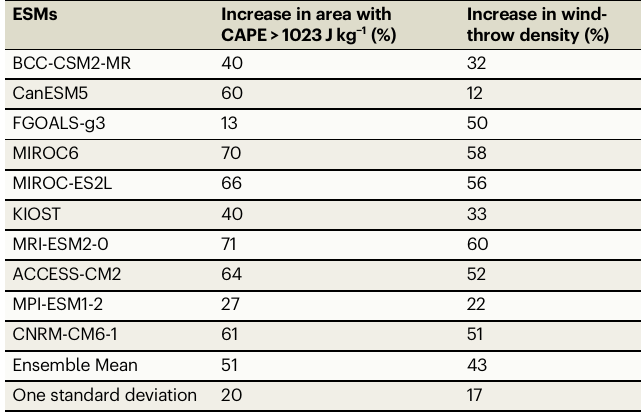
Table 1 | Future changes predicted by Earth system models (ESMs) under the highest emission scenario SSP585 Increase in wind- ESMs Increase in area with throw density CAPE>1023Jkg − 1 (%)